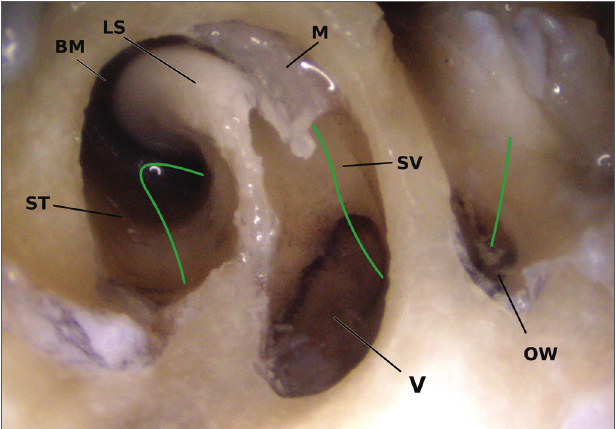
Figura 5. Uma abertura na janela redonda da ovelha (ouvido es- querdo). O estribo foi removido para a inspeção da janela oval (OW). Remanescentes cranianos da membrana de cobertura (M). A lâmina espiral óssea (SL) foi parcialmente ressecada para abrir caminho para a rampa vestibular (SV) e o vestíbulo (V). Podemos identificar também a rampa timpânica (ST) e a membrana basilar (BM). A linha verde exibe o caminho da energia sonora. Após entrar via janela oval, ela passa através do vestíbulo para a rampa vestibular até a ponta da cóclea e continua dentro da rampa timpânica, e então é transmitida via membrana da janela